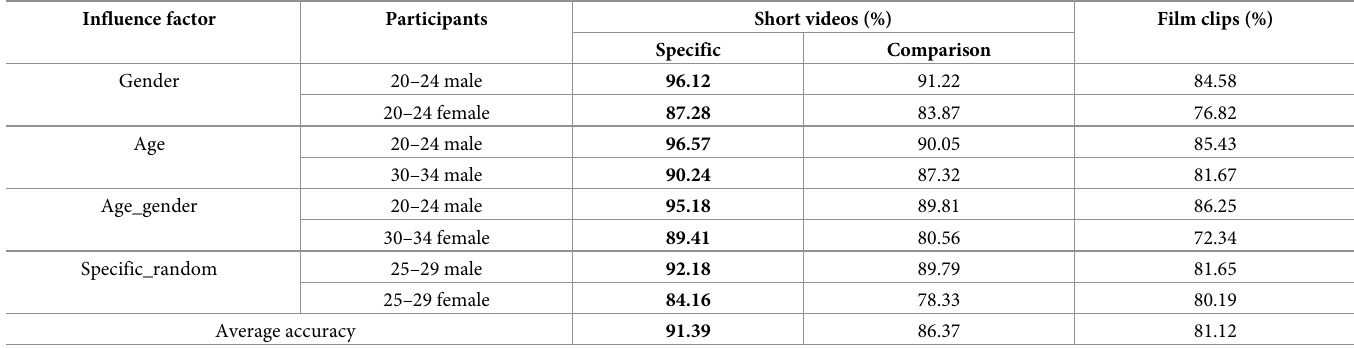
Table 3. The EEG emotion recognition results of different participant groups elicited by different video stimuli. Influence factor Participants Short videos